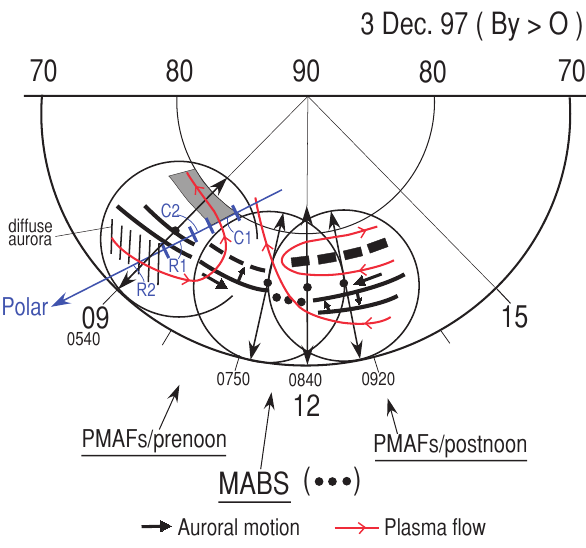
Fig. 5. Schematic of the Polar footpoint track in the context of au- rora and plasma convection in MLT/MLAT coordinates during the interval 05:40–09:30UT on 3 December 1997. Approximate fields of view (assuming a typical 250km altitude for the 630.0nm emis- sions) of the MSP at Ny ˚Alesund are indicated by double-arrowed meridional lines for the times 05:40UT, 07:50UT, and 09:20UT; circles mark the all sky camera fields of view for the same times. Auroral motions are indicated by arrows attached to the respective forms. Plasma convection streamlines are marked red. The shaded sector marks the plasma convection channel associated with the C1- C2 field-aligned currents. denser component injected closer to the central cusp (Smith, 1994). Thus the flow bursts have some of the characteris- tics of flux transfer events (FTEs) ( Russell and Elphic, 1978).